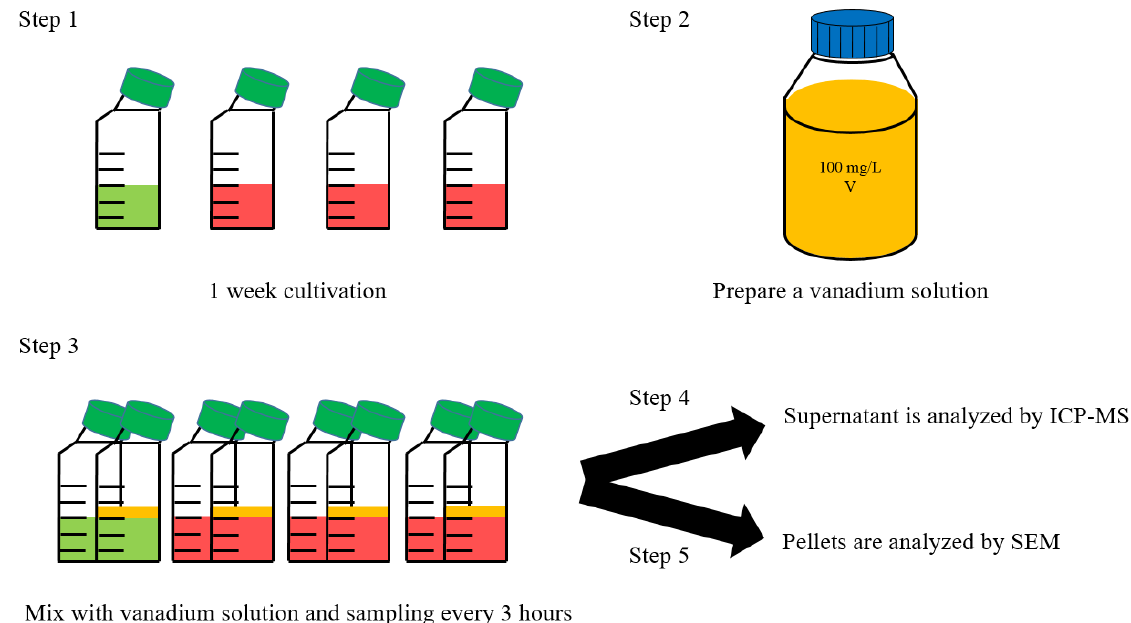
Figure 1. Schematic diagram of scientific vanadium pentoxide ion recycling process.